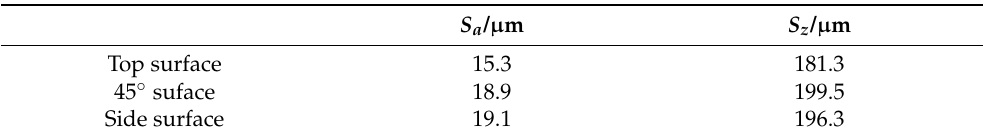
Table 4. The average of S a (average surface roughness) and S z (maximum surface peak/depth) of the three